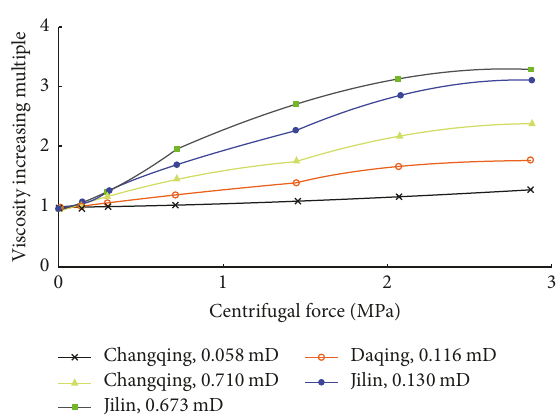
Figure 9: Variation of average in situ viscosity of water in tight rock under different centrifugal